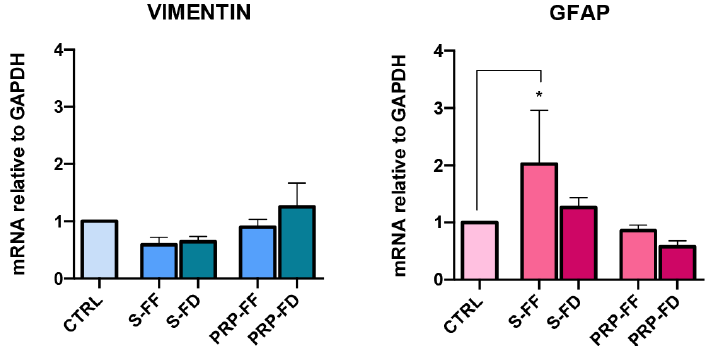
Figure 6. VIMENTIN and GFAP mRNA levels in MIO-M1 cells post-scratch assay at 48 h. Gene expression analysis of the migration marker Vimentin and the activation marker GFAP was performed using Real-Time PCR. Results are reported as the fold changes relative to untreated MIO-M1 cells cultured in DMEM plus 5% FBS and represented as the mean ± standard deviation. Experiments were performed in triplicate. Statistical analyses were performed using one-way ANOVA followed by Tukey’s multiple comparisons test. GFAP: * p = 0.0308 CTRL vs. S-FF.